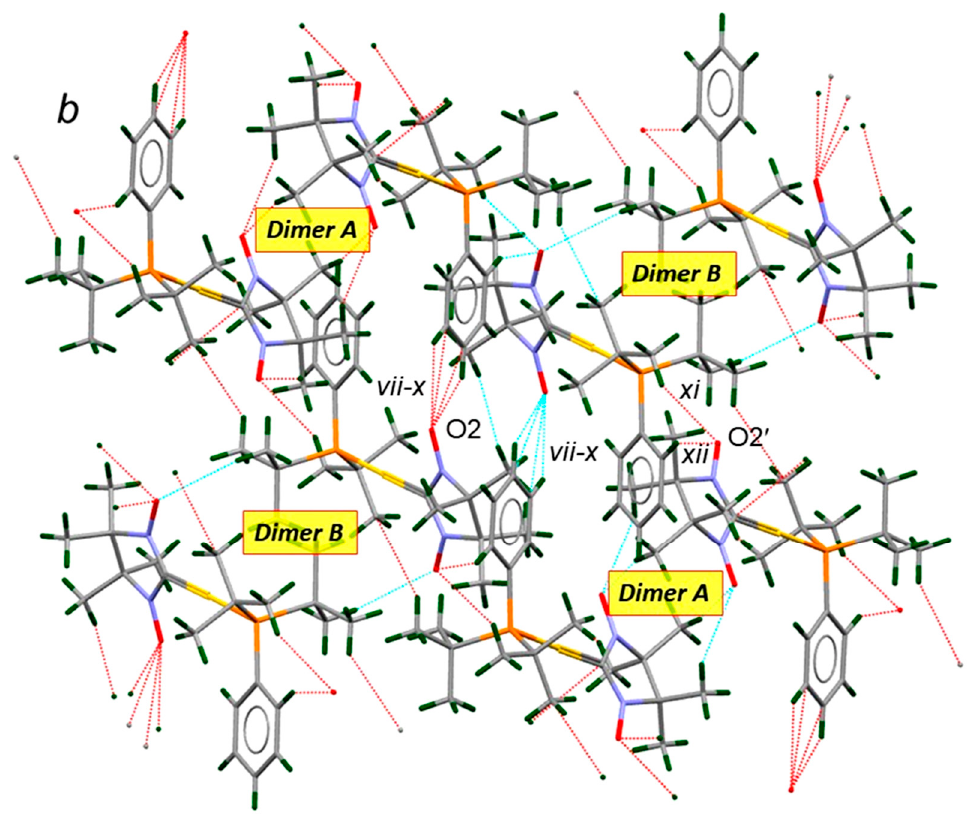
Figure 6. Short intermolecular contacts and interatomic distances in crystals of NN-Au-P t Bu 2 Ph ( 2 ): two dimers A and B consisting of independent molecules ( a ), binding of the dimers info a 3D framework via contacts viii-xii ( b ). Table 2. The parameters of short contacts and interatomic distances for NN-Au-PPh 3 [4], NN-Au- P t BuPh 2 ( 1 ), and NN-Au-P t Bu 2 Ph ( 2 ). C ′ corresponds to an analogous carbon atom in another independent structure of NN-Au-P t Bu 2 Ph.